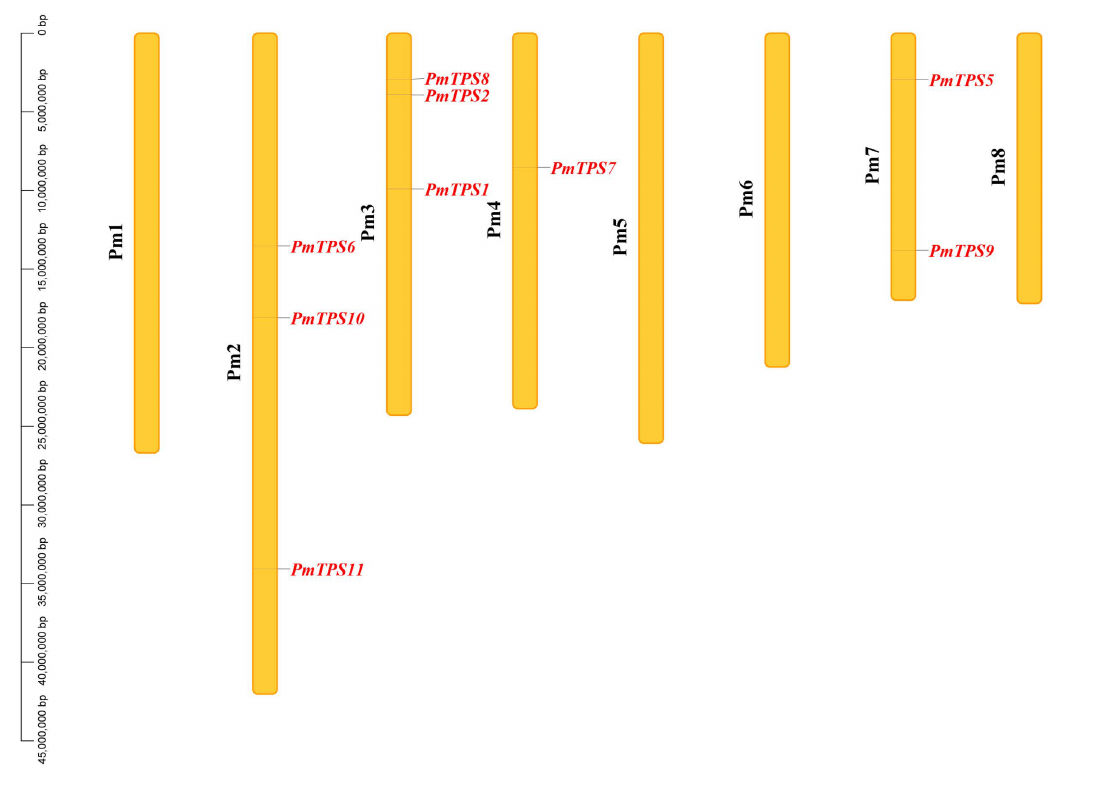
Figure 3. Chromosomal location of trehalose-6-phosphate synthase (TPS) family genes in Prunus mume . Nine TPS genes were located in four chromosomes. Pm1, Pm2, Pm3, Pm4, Pm5, Pm6, Pm7, and Pm8 represent eight chromosomes of P. mume ,